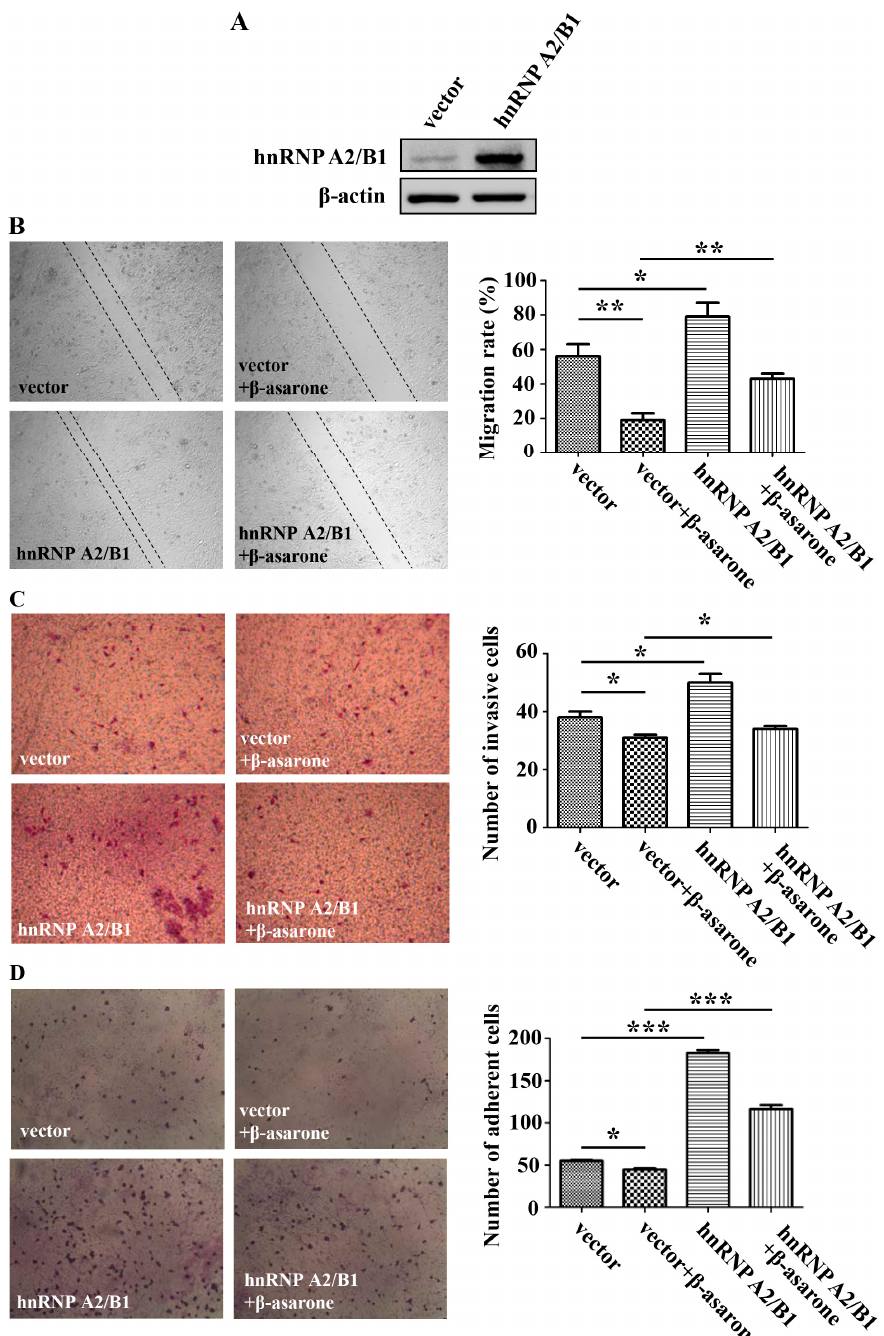
Figure 5. hnRNP A2/B1 overexpression reversed the inhibitory effect of β -asarone on migration, invasion, and adhesion. ( A ) The level of hnRNP A2/B1 was measured by Western blotting after U251 cells were transfected with pCMV3 or pCMV3-hnRNP A2/B1 for 48 h; ( B ) Migration assay. After being transfected with pCMV3 or pCMV3-hnRNP A2/B1 for 24 h, cells were seeded on each side of an Ibidi culture insert overnight and then treated with β -asarone (60 μ M) or vehicle for 48 h; ( C ) Boyden chamber invasion assay. After being transfected with pCMV3 or pCMV3-hnRNP A2/B1 for 24 h, U251 cells were pretreated with β -asarone (60 μ M) or vehicle for 24 h and then seeded in the chamber with coated Matrigel of a 24-transwell plate for another 24-h invasion assay; ( D ) Adhesion assay. After being transfected with pCMV3 or pCMV3-hnRNP A2/B1 for 48 h, U251 cells were preincubated with β -asarone (60 μ M) or vehicle for 24 h and seeded onto a 96-well plate coated with Matrigel for 4-h adhesion. Then, attached cells were stained and counted. Randomly chosen fields were obtained using an optical microscope (100× magnification). Values represent mean ± SD. * p < 0.05, ** p < 0.01, and *** p < 0.001.